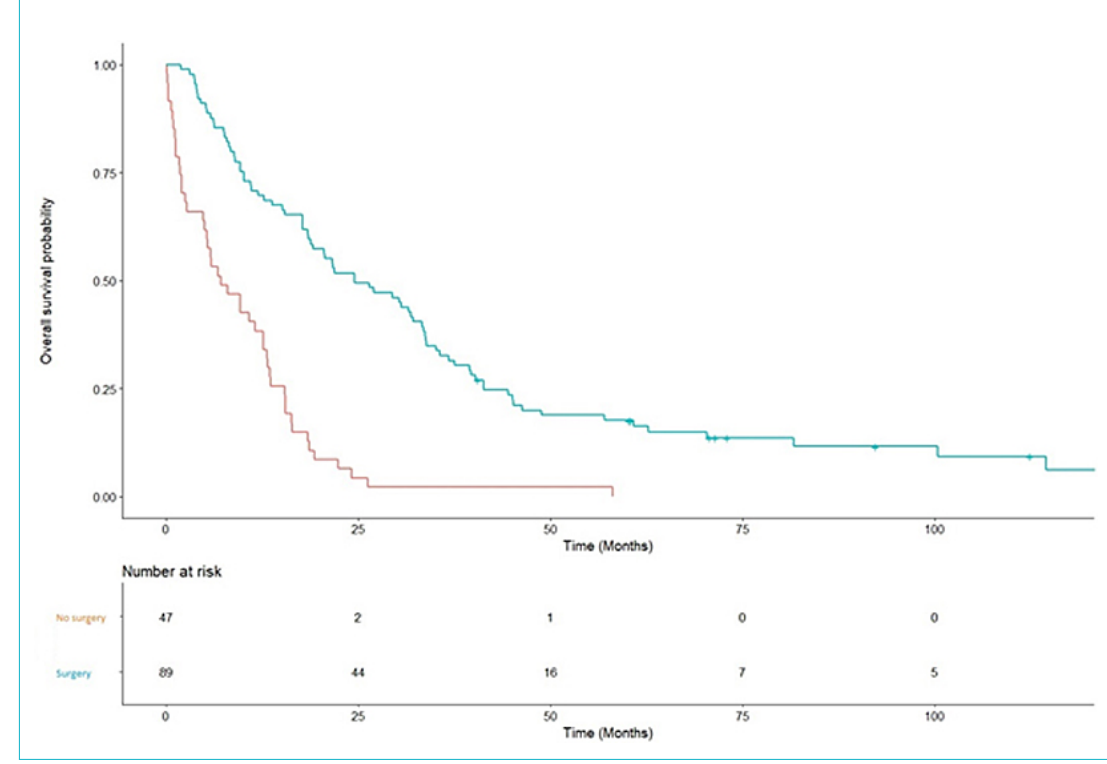
Figure 1: Overall survival when rectal surgery was performed or